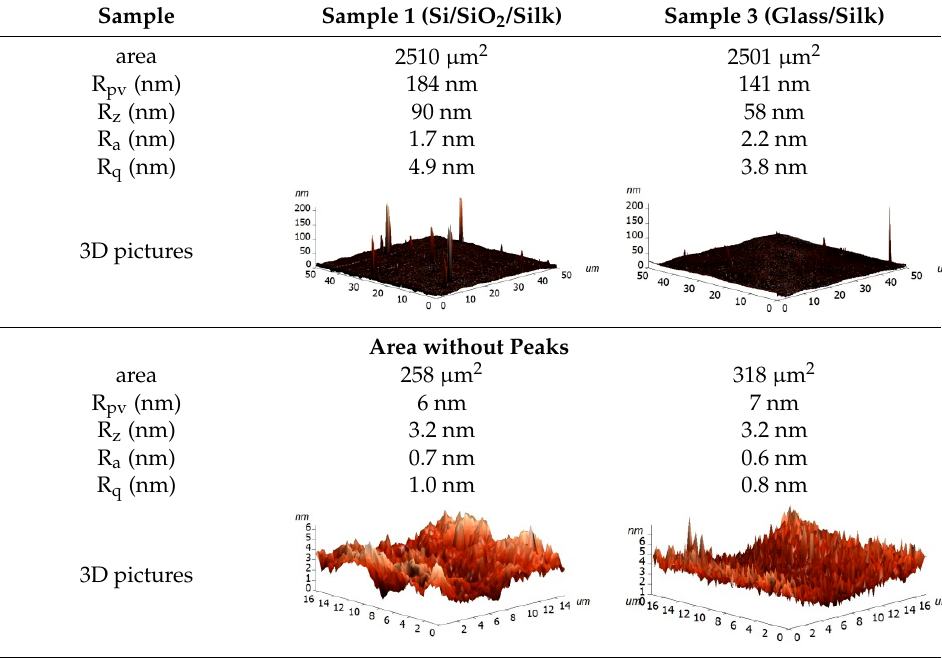
Table 2. Atomic force microscopy (AFM) measurement of the silk layer deposited on Si/SiO 2 (sample 1) and on borosilicate glass substrates (sample 3).